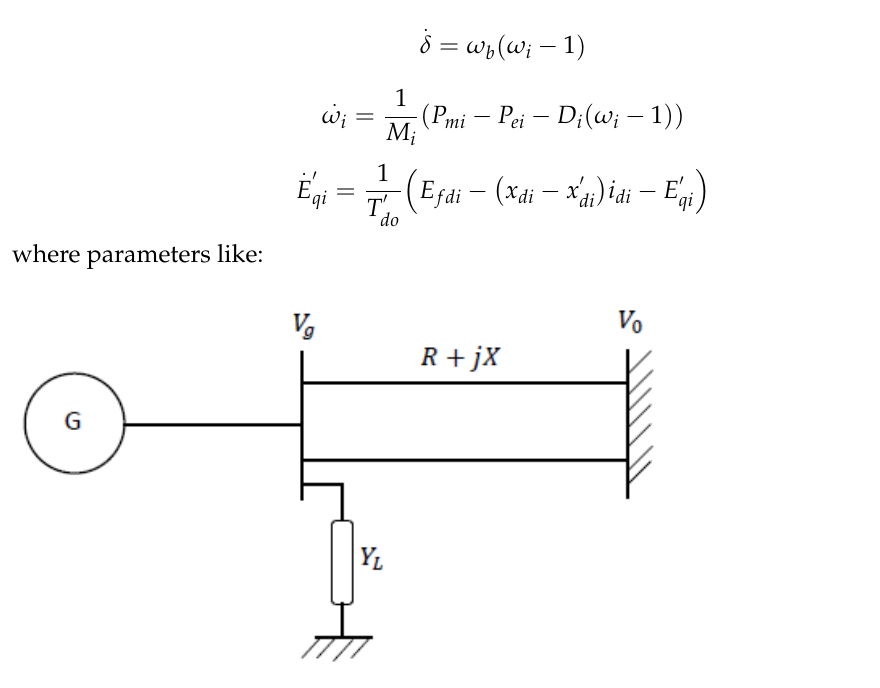
Figure 1. SMIB test system.